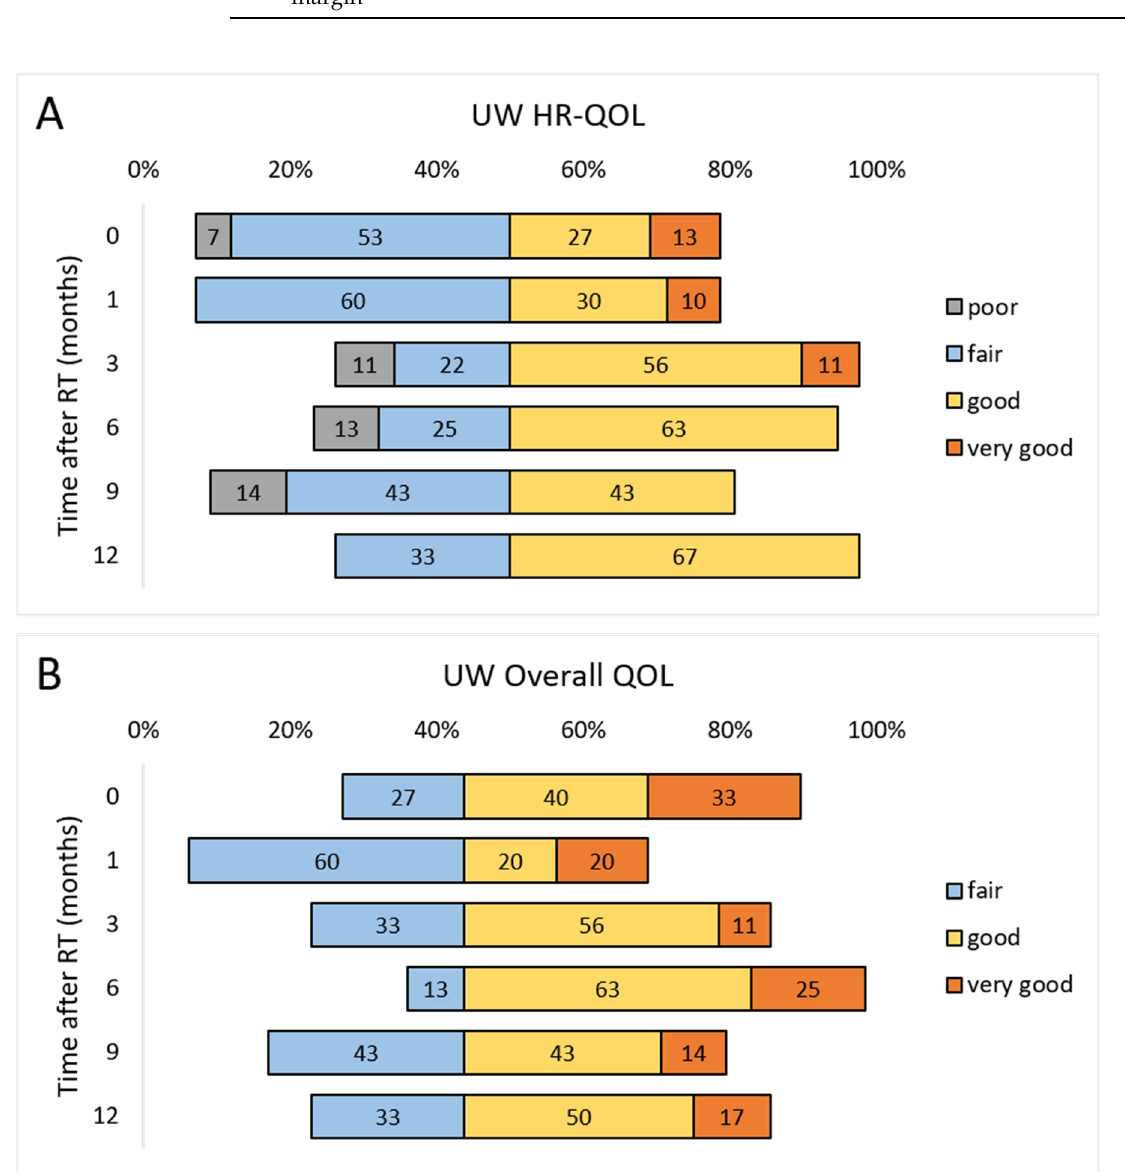
Figure A1. Patient-reported quality of life scores based on the UW-QOL questionnaire at baseline and at 1, 3, 6, 9 and 12 months after treatment. ( A ) Health-related QOL scores; ( B ) Overall QOL scores.